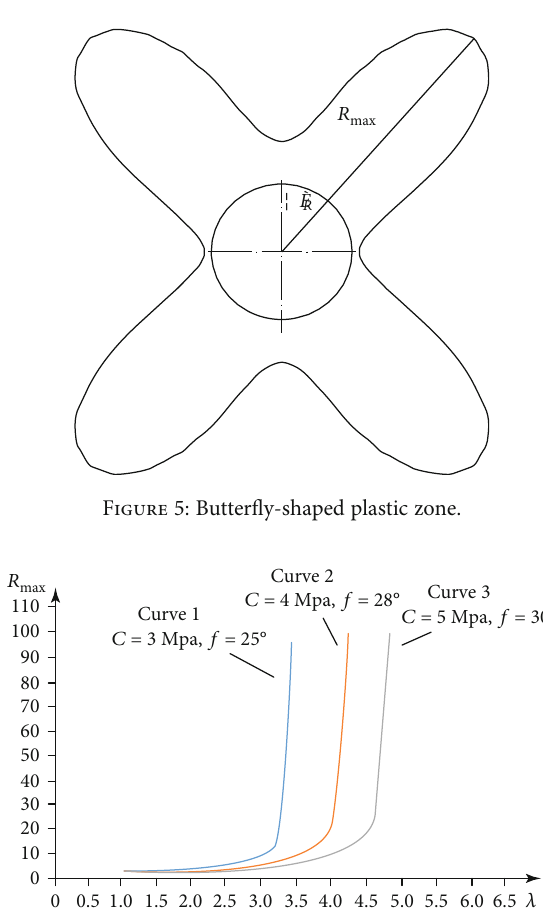
Figure 6: Trend of butter fl y leaf radius with lateral pressure coe ffi cient.